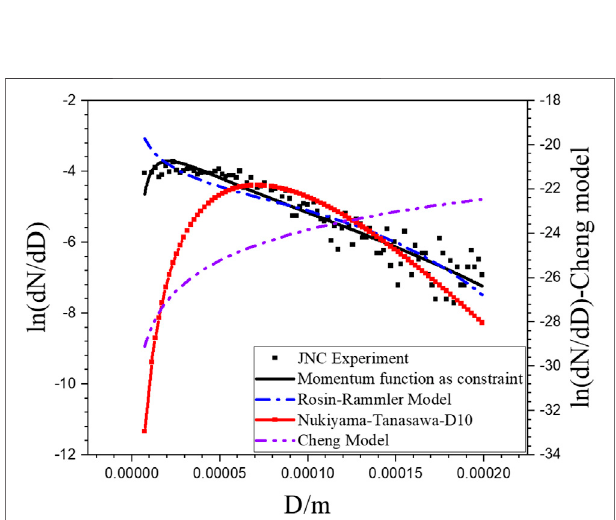
FIGURE 12 | Comparison of Nukiyama-Tanasawa model with D10, Cheng model, Rosin-Rammler model and the proposed sodium spray model with JNC experimental